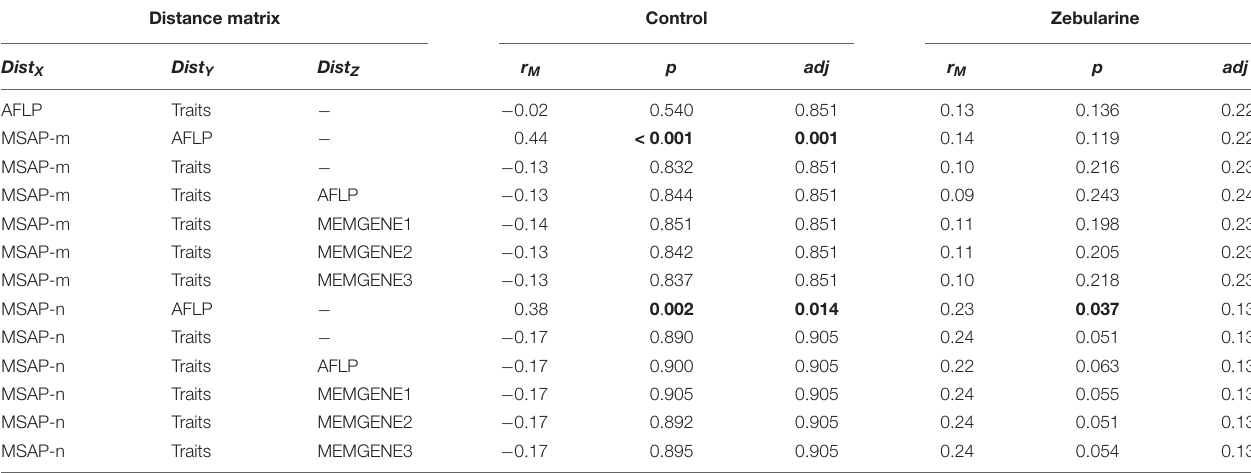
TABLE 2 | (Partial) Mantel tests conducted between phenotypic (Traits), genetic (AFLP) and epigenetic variation (MSAP-m; MSAP-n) separately for control and zebularine-treated plants. Distance matrix Control